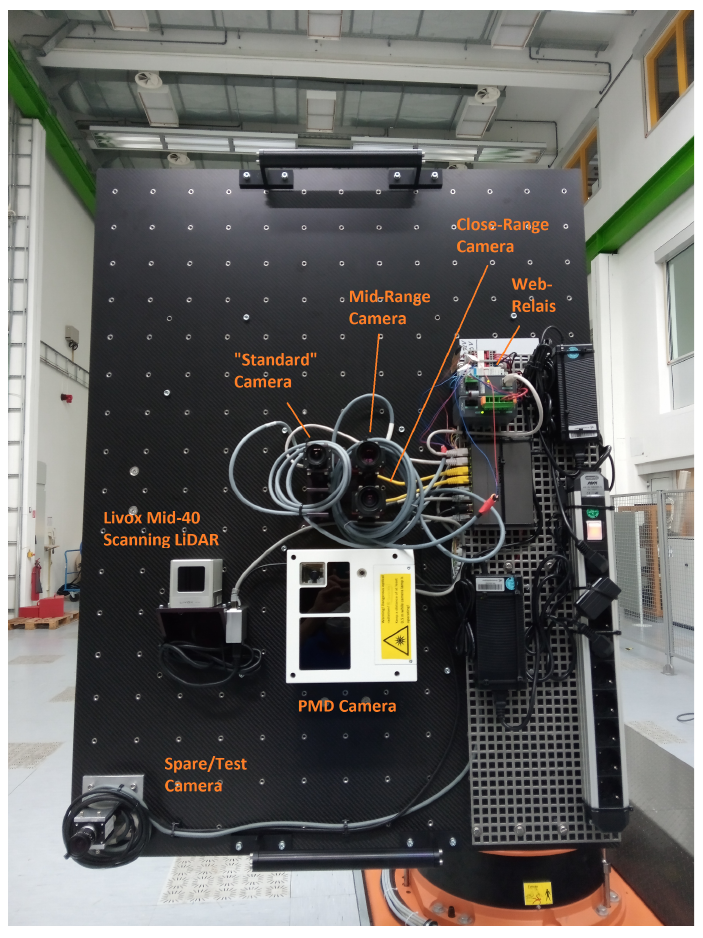
Figure 17. Carbon fiber composite breadboard with rendezvous sensors mounted to robot 1. Right: power supplies, network switch and other supporting equipment. Center: standard camera, mid- and close range cameras and new PMD camera by Bluetechnix in white. Left: Livox Mid-40 scanning